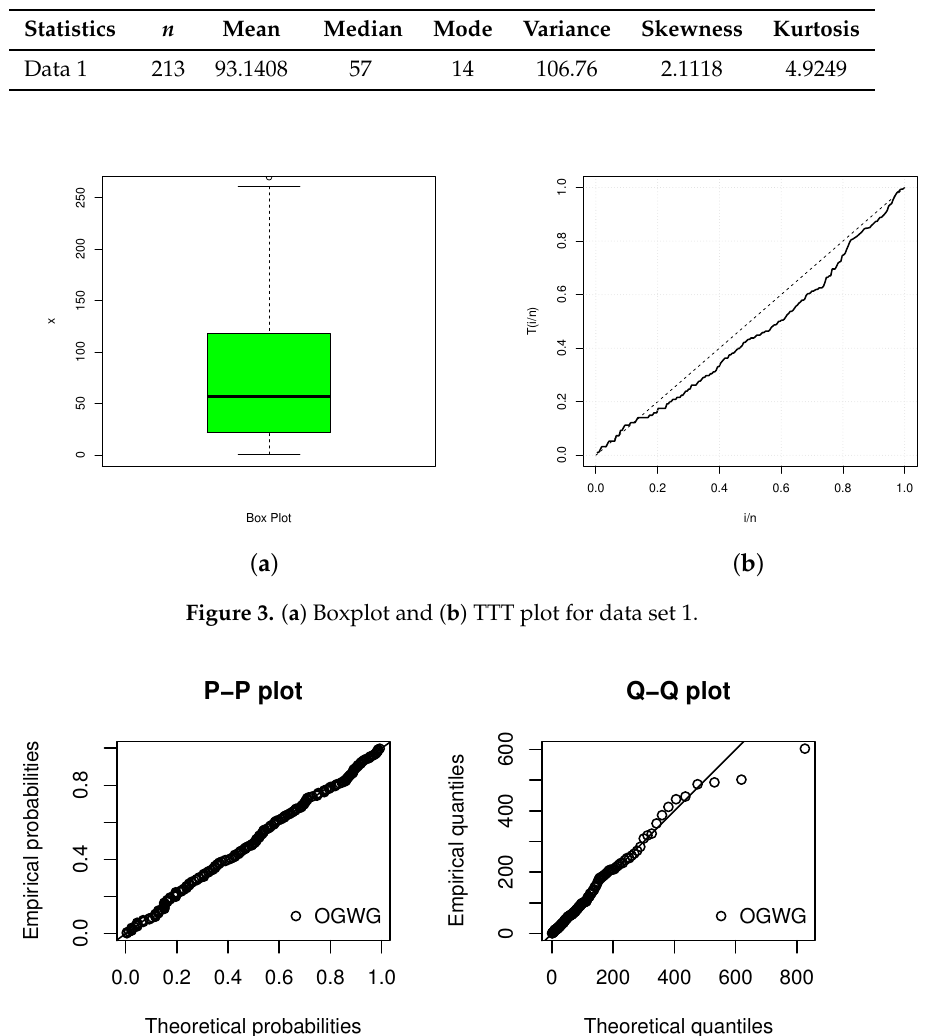
Table 3. Descriptive statistics for data set 1.